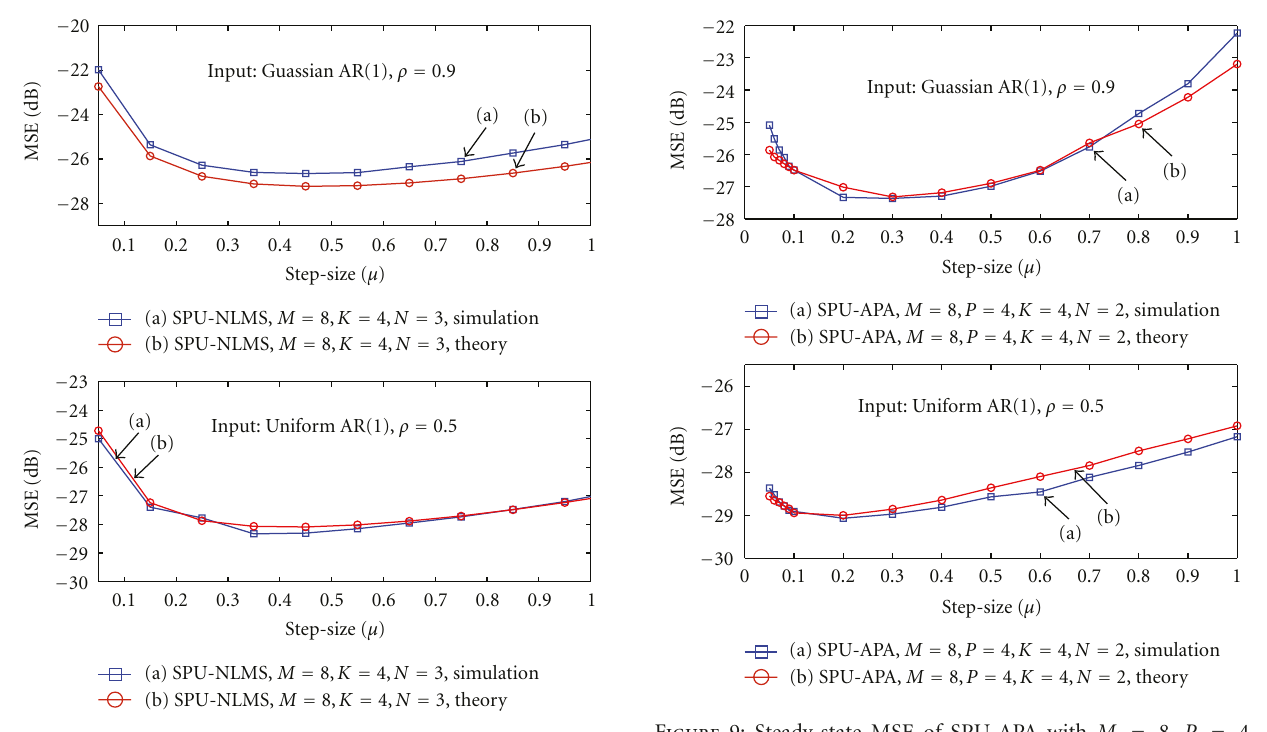
Figure 7: Steady-state MSE of SPU-NLMS with M = 8, K = 4 and N = 3 as a function of the step size in nonstationary environment for di ff erent input signals.